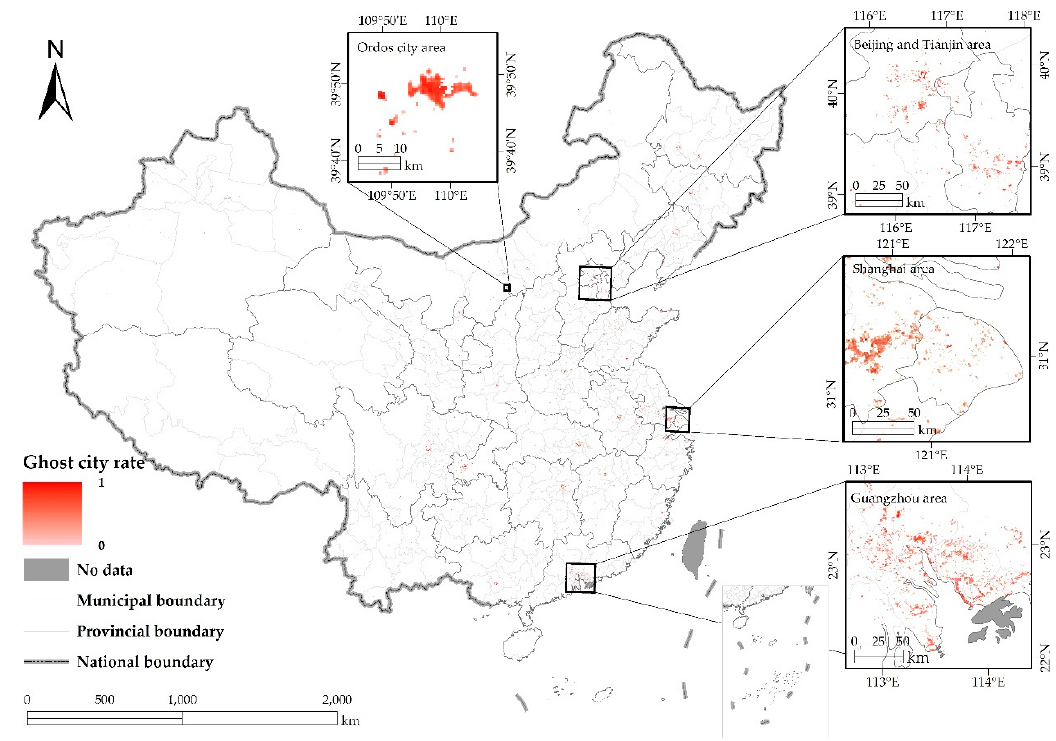
Figure 3. Spatial distribution of China’s ghost city rate in 2013. The four regions are magnified and shown in detail.